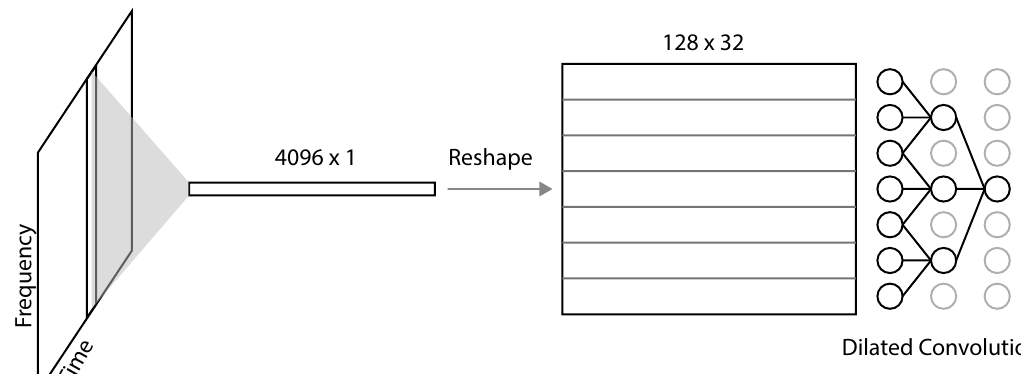
Figure 2. Schematic depiction of the Frequency Aggregation module for one time-frame . The frame is filtered with 4096 kernels resulting in filter responses of size 4096 × 1 ( Conv4 in Table 1). By reshaping, the responses are then separated into 32 groups (of size 128 each) and re-combined again through a stack of dilated convolutions ( Conv5 – Conv14 in Table